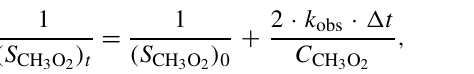
4 . 9 × 10 − 13 molecule − 1 cm 3 s − 1 , consistent with that recom- mended by IUPAC, (4 . 8 ± 0 . 6 ) × 10 − 13 molecule − 1 cm 3 s − 1